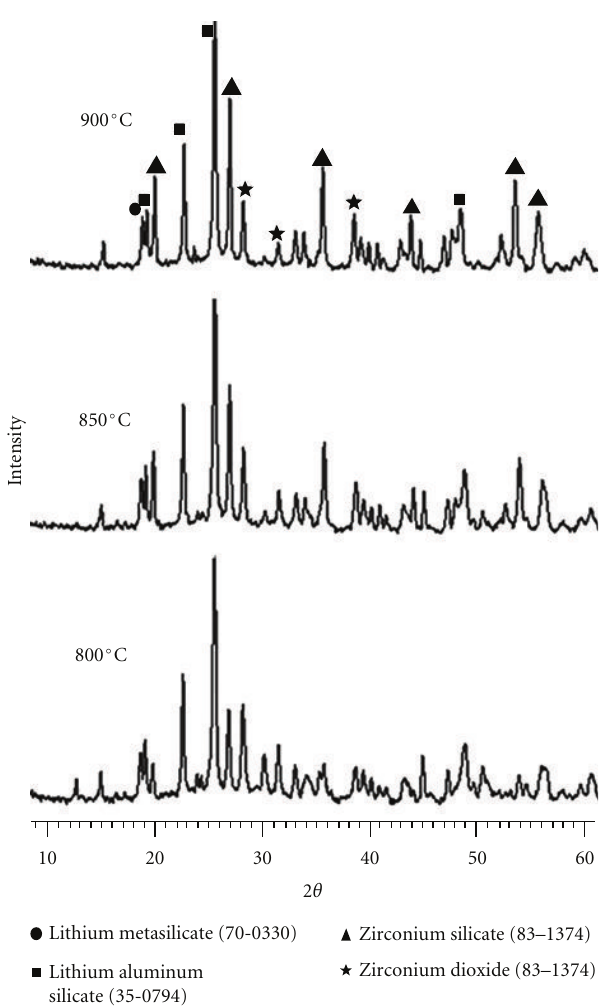
Figure 5: Development of phases in LZSA as a function of temperature (all runs were made in 60 min).